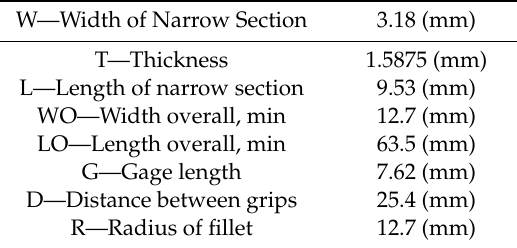
Table 1. Dimensions of the dog-bone sample.